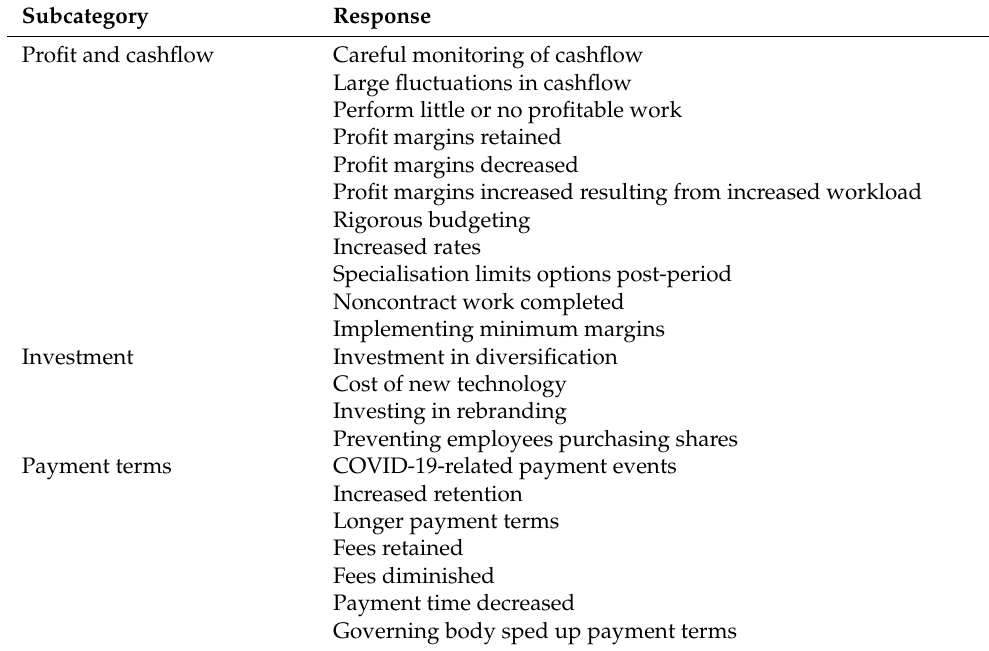
Table 6. Financially related